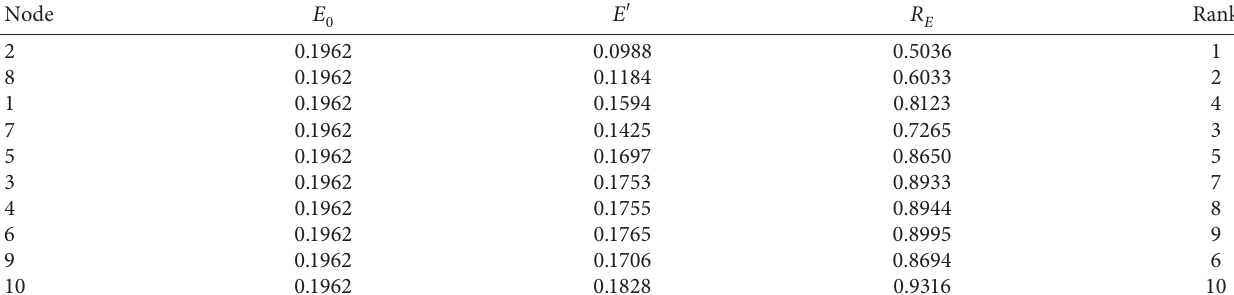
Table 4: The robustness analysis results of experimental traffic network under deliberate attack.